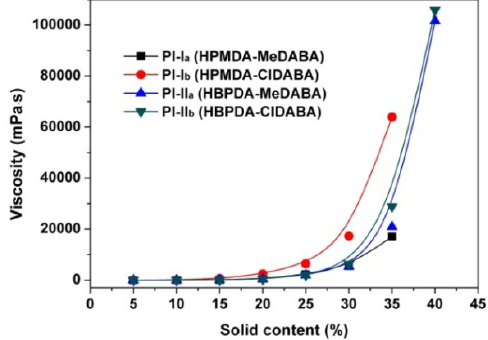
Figure 2. Viscosity–solid content relationship of the PI solutions (Solvent: DMAc).